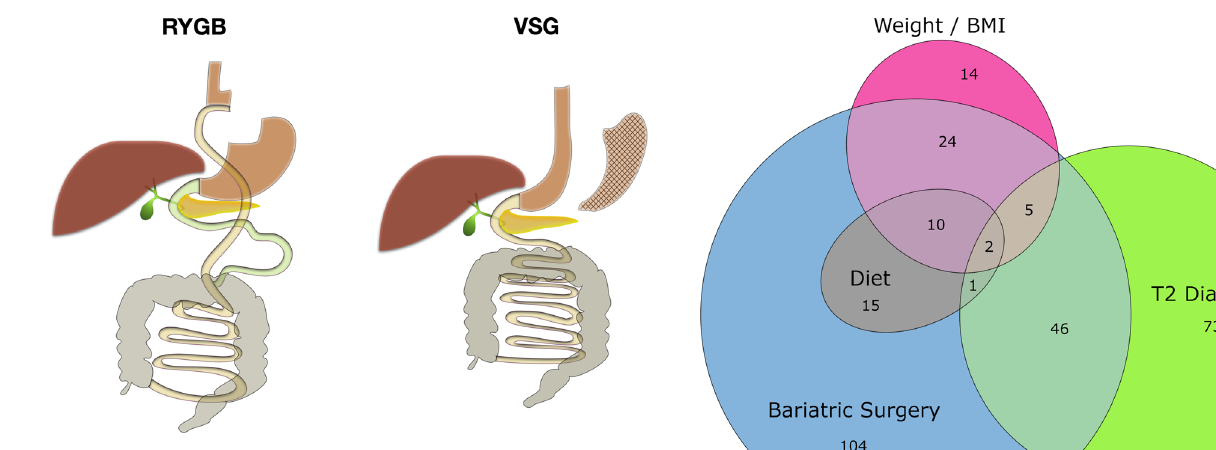
Fig. 1 RYGB and VSG weight loss procedures. Schematic of Roux-en-Y Gastric Bypass (RYGB) and Vertical Sleeve Gastrectomy (VSG) procedures, showing the respective anatomical changes.